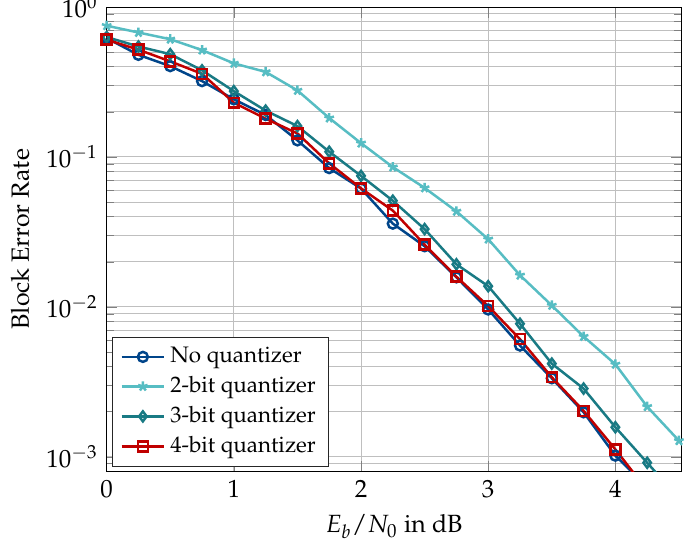
Figure 16. Block error rate of double-precision floating-point SCL decoder with channel quantizers of different resolutions designed using the information bottleneck method. N L = 32 without the outer CRC code, N = 128, code rate 0.5, and design E b / N 0 = 3